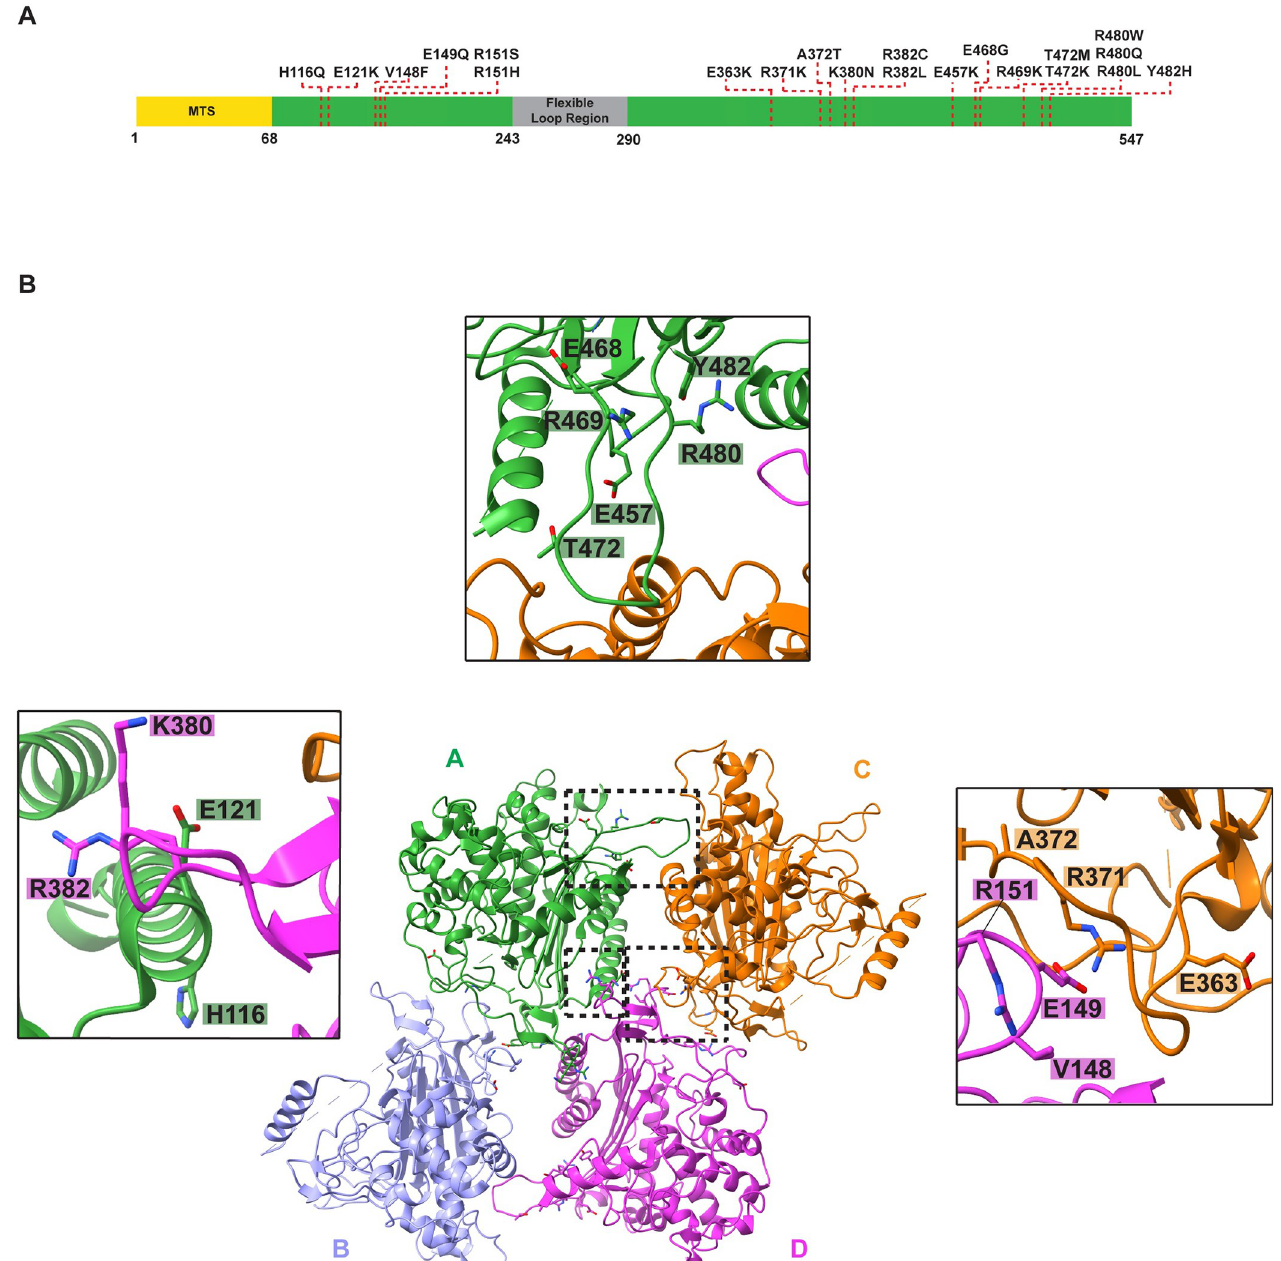
Fig 6. The model of LACTB enables mapping the disease-associated mutations. ( A ) A schematic representation of full-length LACTB architecture. Residues 1–68 contain the predicted MTS and residues 243–290 form the flexible loop region. Residues that are associated with various human cancers are highlighted with a red dashed line. ( B ) Ribbon diagram of human LACTB tetramer. Protomers that form the tetramer are labeled A to D and colored as in Fig 4A . Mutations localizing to oligomerization interfaces are illustrated as sticks. Inset windows show the close-up views of oligomerization interfaces containing disease-associated mutations. Black boxes indicate the dimer and polymerization interfaces 1 and 2, respectively. MTS, mitochondrial targeting